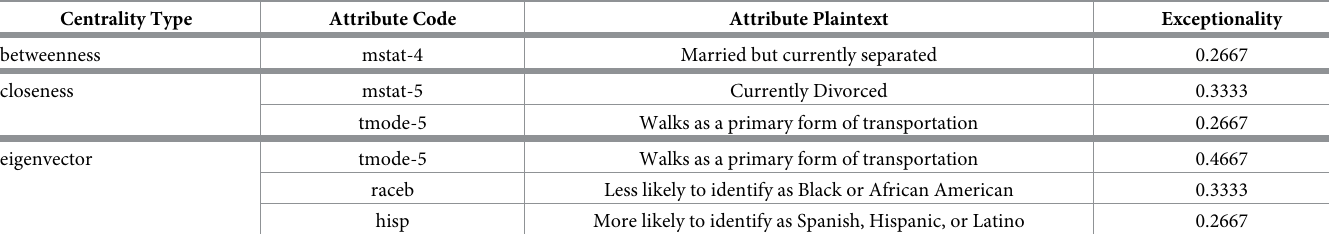
Table 1. Exceptional attributes of